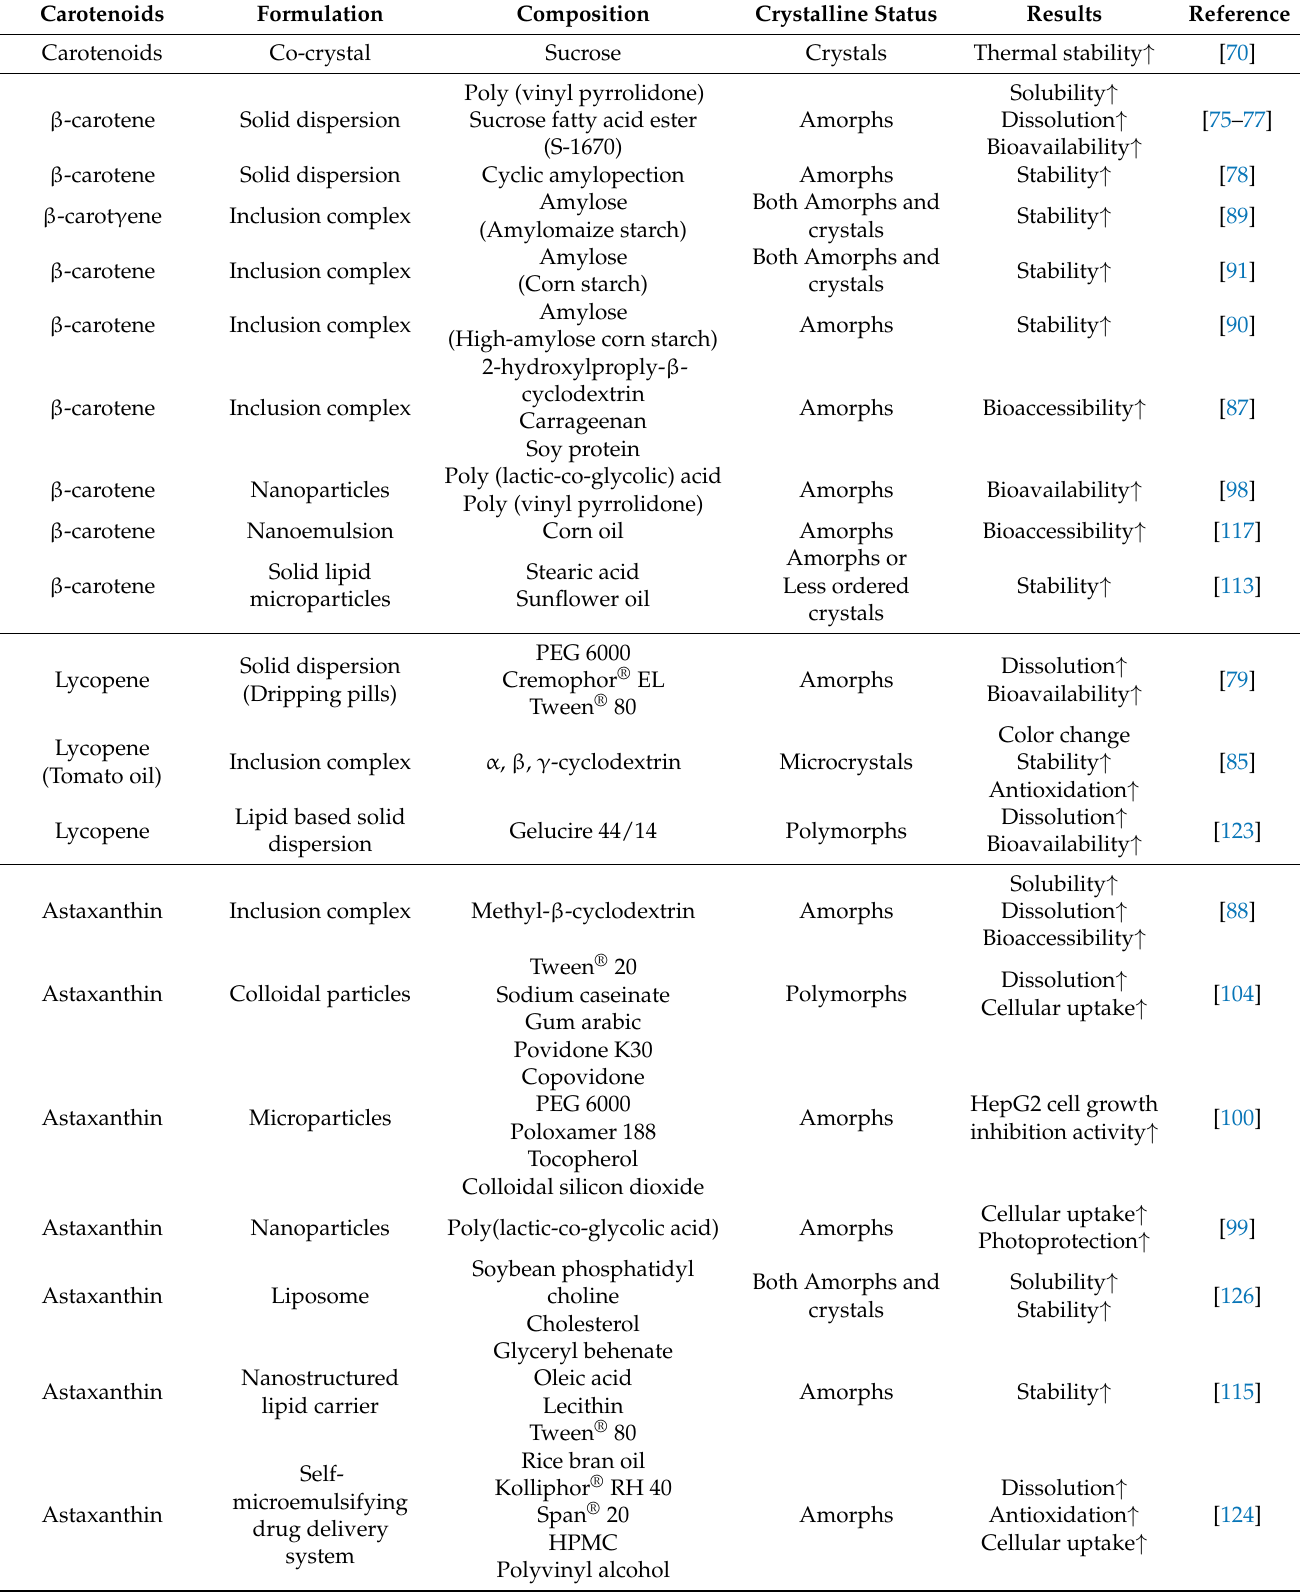
Table 2. The summary of carotenoid formulations involved in the crystalline